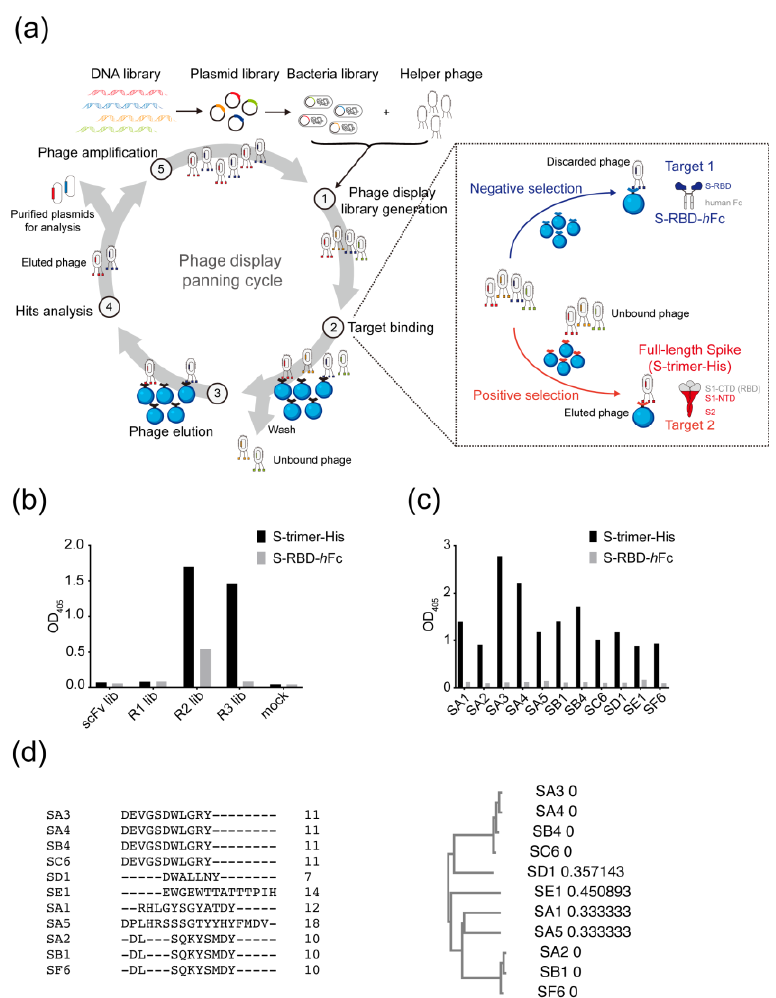
Figure 1. Combinatorial antibody library screening for non-RBD targeting antibodies against SARS- CoV-2. ( a ) Schematic representation of a 5-step phage panning cycle ( ① – ⑤ ). The insertion box describes a detailed alternate negative (highlighted in blue)/positive (highlighted in red) selection strategy for step ② of the Target binding. ( b ) Phage ELISA results of three rounds of panning against S-RBD- h Fc (grey) and S-trimer-His (black). ( c ) Phage ELISA results of enriched 11 unique clones of round 3 against S-RBD- h Fc (grey) and S-trimer-His (black). ( d ) Amino acid sequence alignment of CDR-H3 of the enriched antibodies by multiple sequence alignment in CLUSTAL O (1.2.4). The numbers besides the clone names in the right panel represent the branch lengths, indicating the evolutionary distances between two consecutive nodes in the phylogenetic tree.